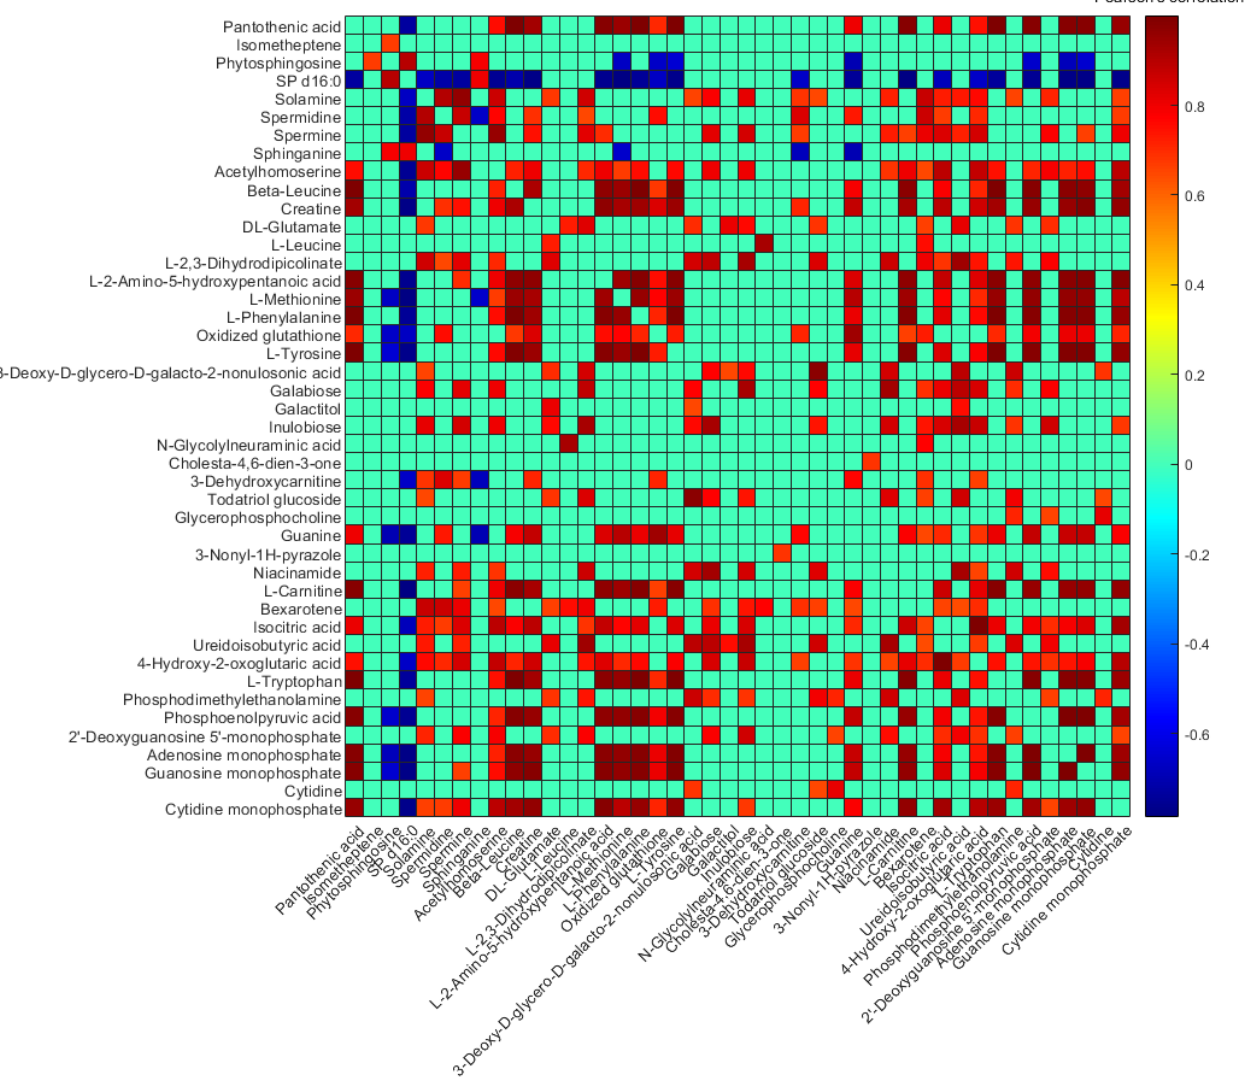
Figure 5. Pearson’s paired correlation between unique metabolites. Note: For better visualization, those correlations considered non-significant ( p -value < 0.01) are given an r-value = 0, and those metabolites that did not correlate significantly with any other metabolite are not shown.